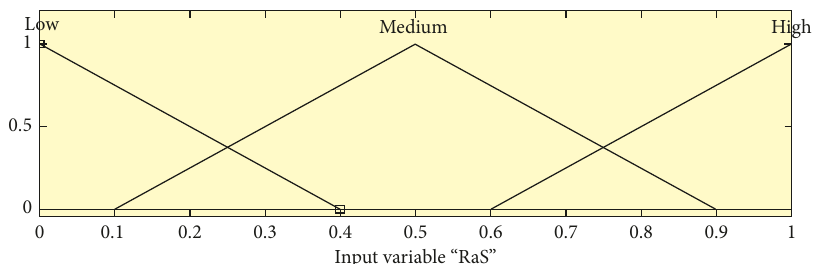
Figure 8: Triangular membership function used in the